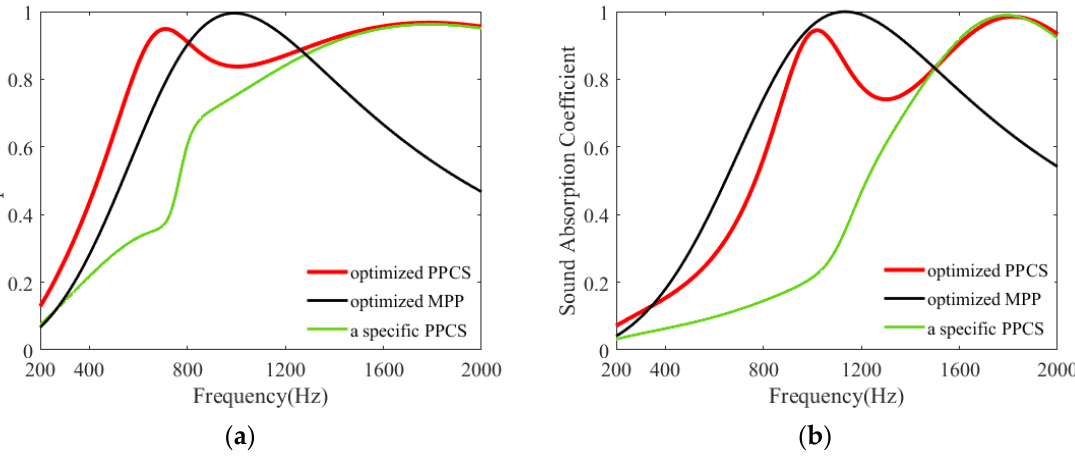
Figure 7. Sound absorption coefficients of optimized PPCS, optimized MPP, and a specific PPCS (the same PPCS structure without porous-material filling in the PR). ( a ) Porous materials of melamine with a thickness of 40 mm; ( b ) porous materials of polyurethane with a thickness of 30